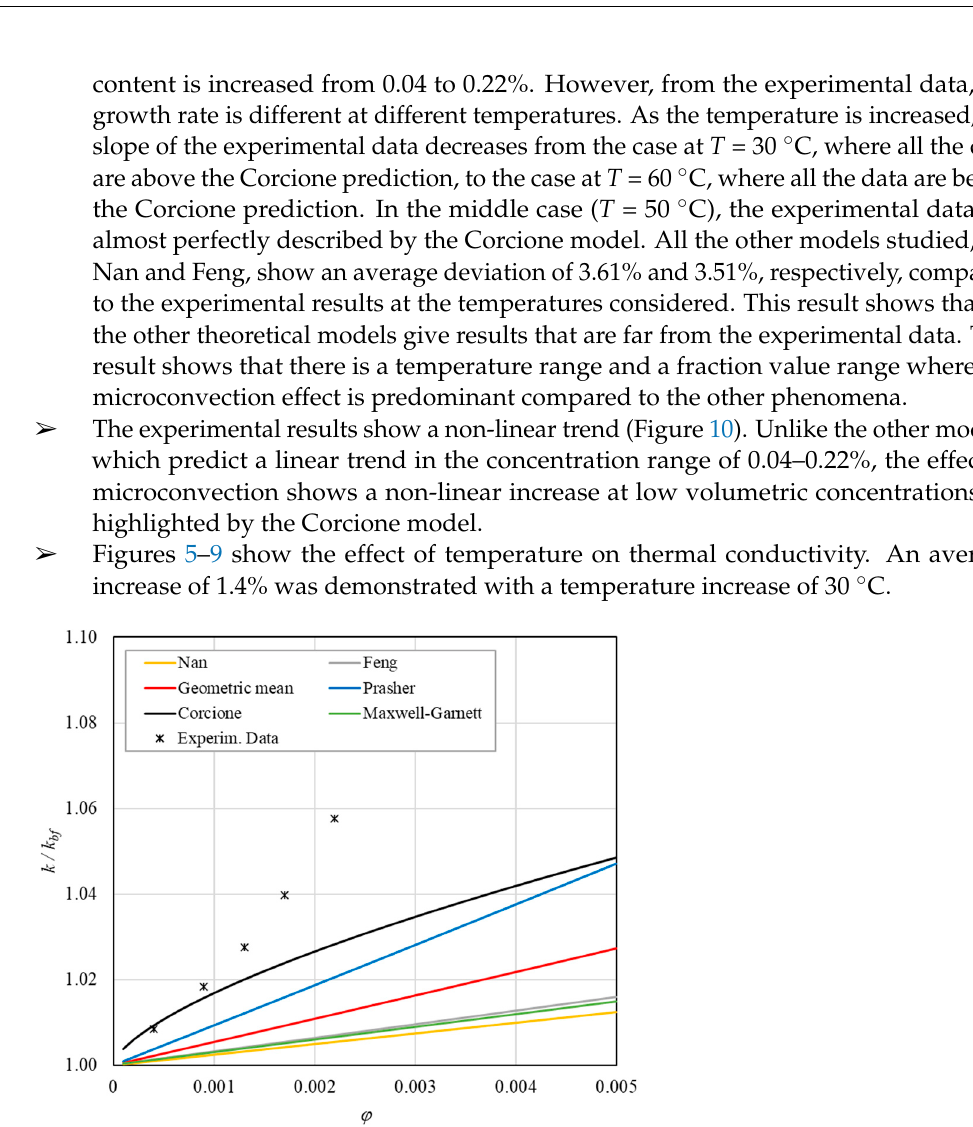
Figure 10. Increase in thermal conductivity versus volumetric content for engine oil (Castrol Magnatec 10W40)—Alumina (d = 50 nm) at 30 °C.